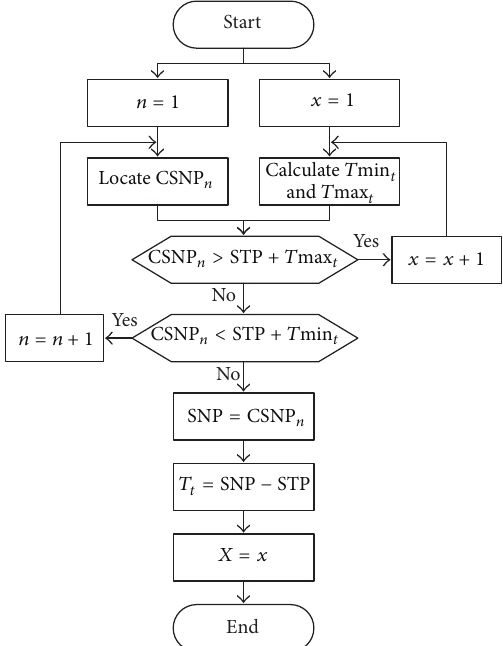
Figure 4: SNP, 𝑇 𝑡 , and 𝑋 determination